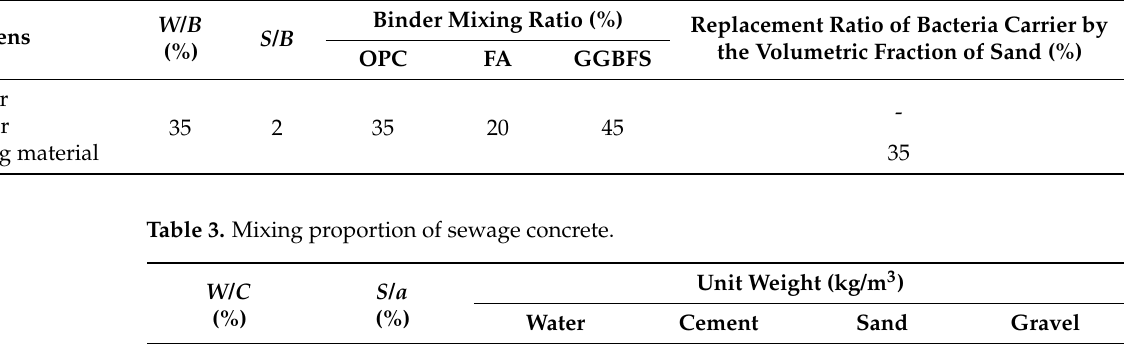
Table 2. Mixing proportions of repair mortar and bacteria-coating material.